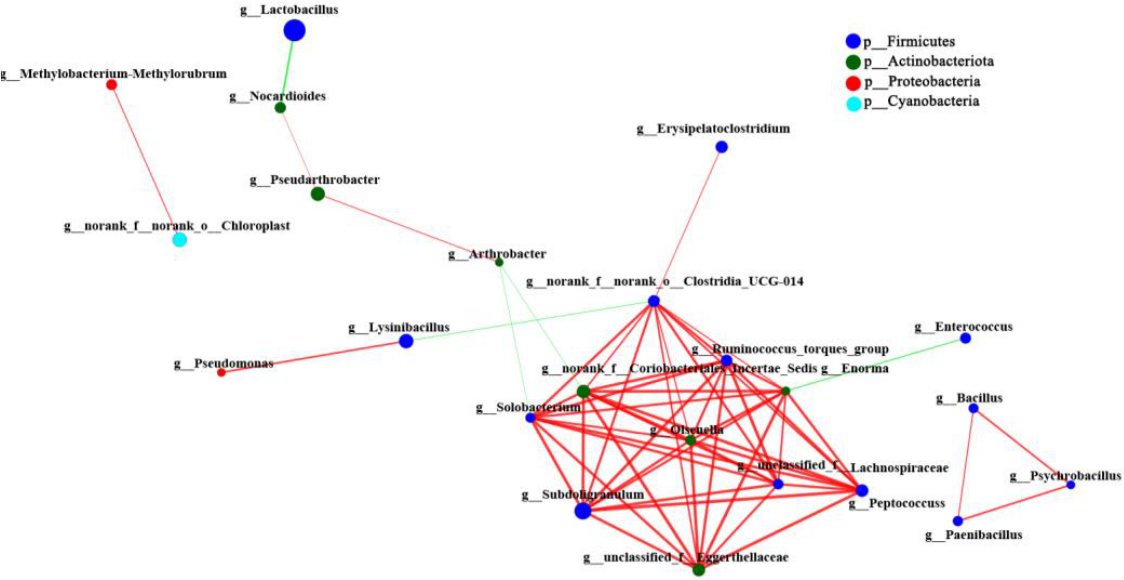
Figure 6. Single factor correlation network analysis of intestinal microbiota of CL Anser fabalis . At the genus level, the network collinearity network analysis was carried out for the intestinal microbiota of SL and CL A. fabalis . As shown in Figure 7, the two sample collinear network species have 18